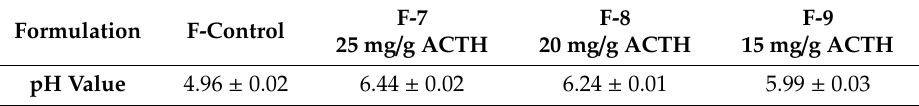
Table 1. The pH values determined for the semi-solid formulations tested ( p < 0.05).